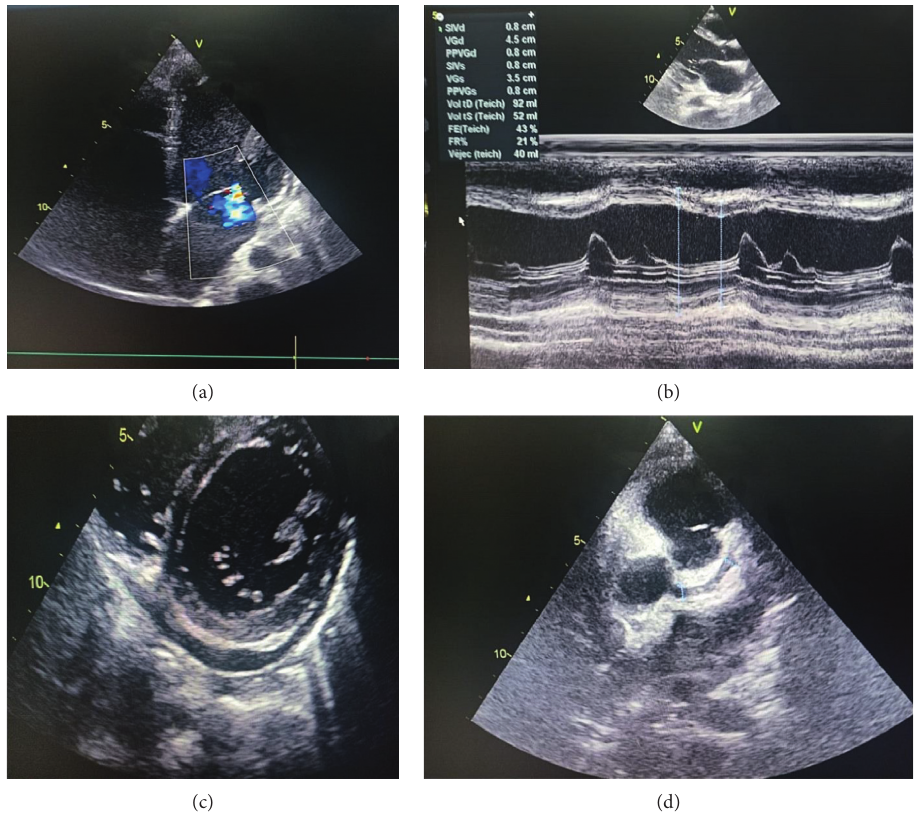
Figure 4: Echocardiographic images showing (a) mitral regurgitation, (b) low left ventricular ejection fraction at 43%, (c) pericardial effusion, and (d) 4mm coronary dilatation ( Z score +4).